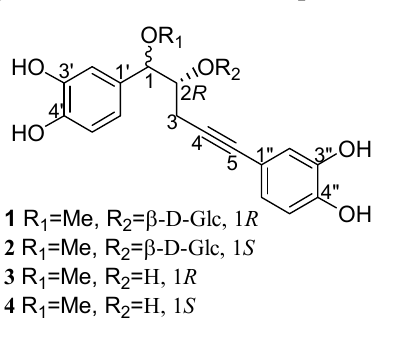
Figure 1. Structures of compounds 1 - 4